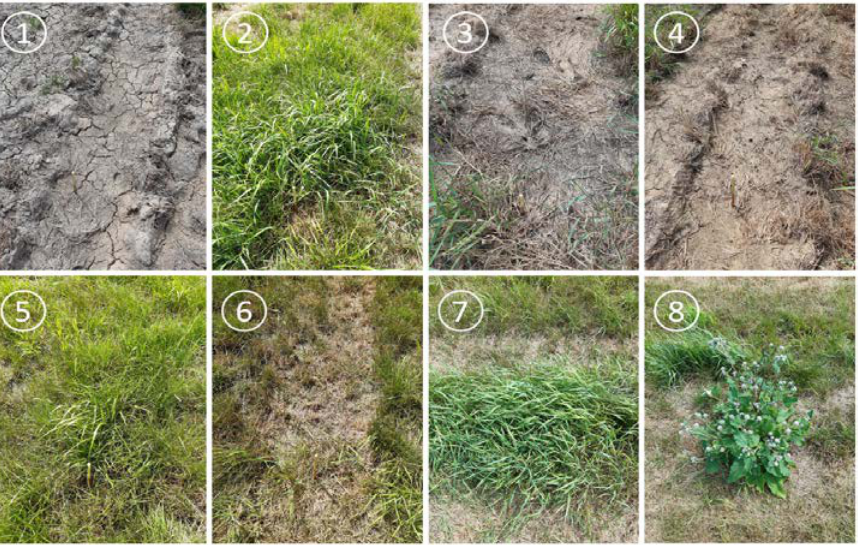
Figure 3. Eight study points in the examined field where regular in situ NDVI measurements were taken on 29 July 2020.